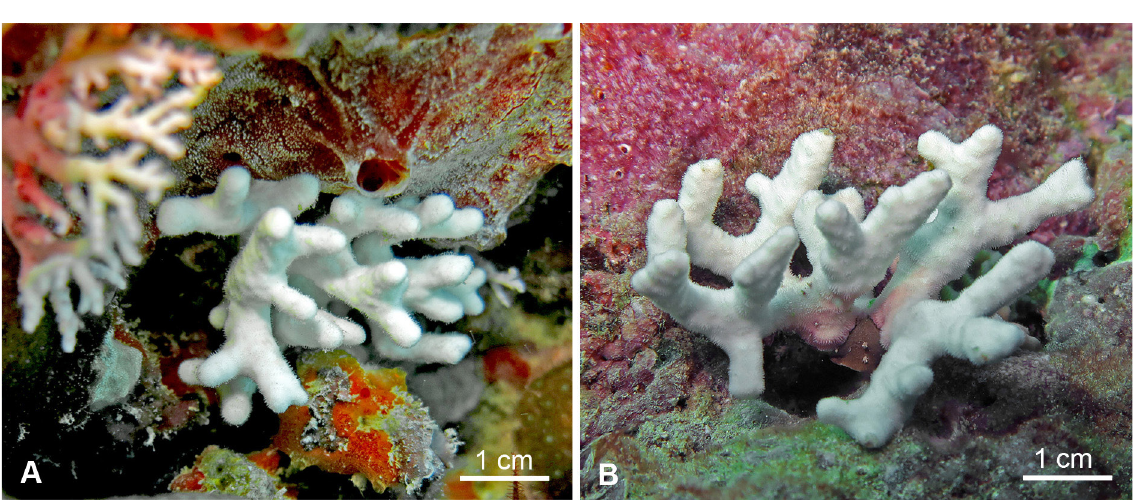
Fig. 1. Underwater photos of specimens of Disporella guada Harmelin, Taylor & Waeschenbach sp.